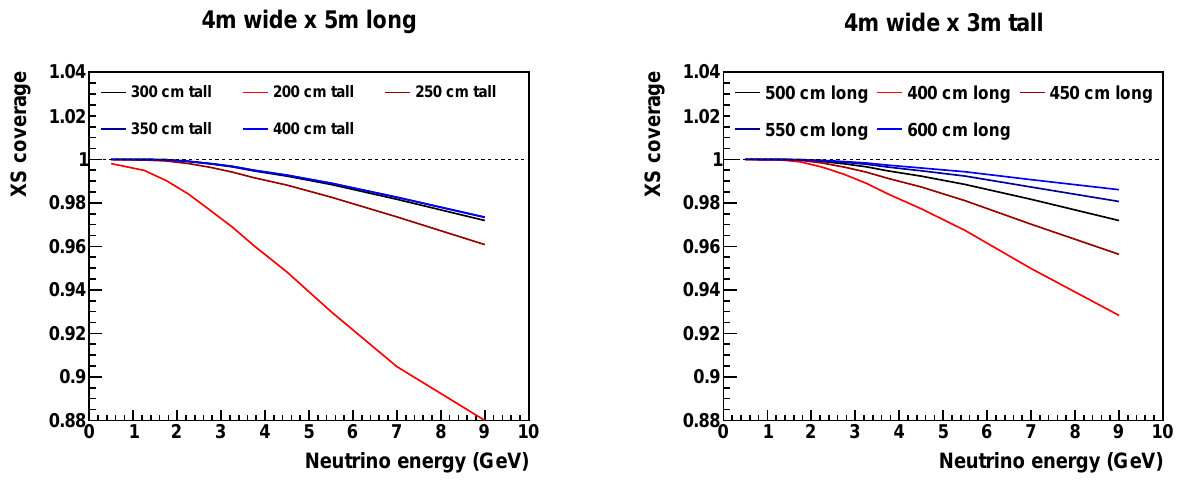
Figure 33. The cross section coverage, defined in the text, is shown for various LArTPC heights ( left ) and widths ( right ) as a function of true neutrino energy. In each plot, the other two dimensions are held constant at the baseline values while the third is varied. The optimal dimensions for hadron containment are determined to be 4m